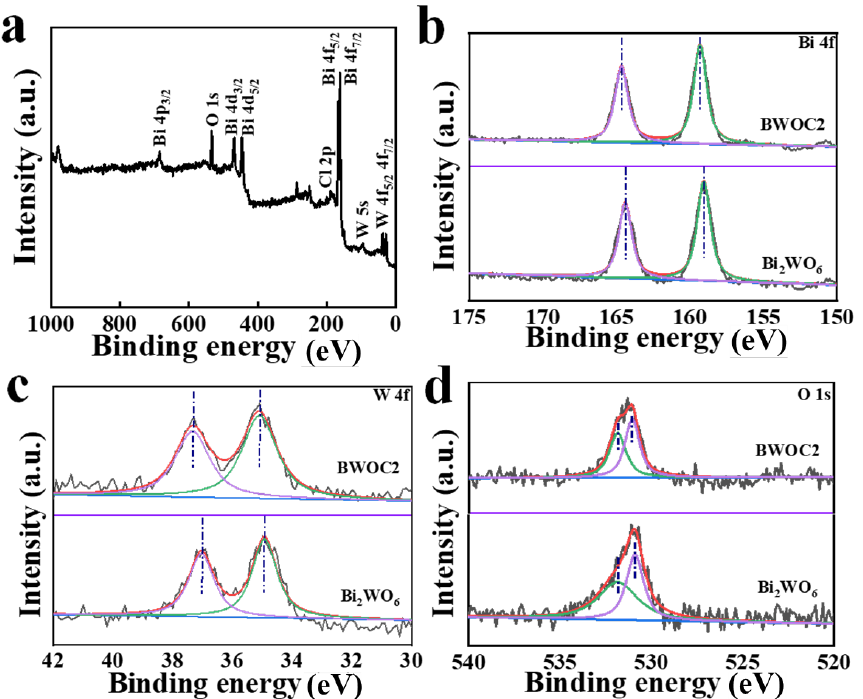
Figure 4. XPS spectra of BWOC2 sample: ( a ) survey spectrum, ( b ) Bi 4f, ( c ) W 4f, and ( d ) O 1s. If the peaks of Bi 4f 7/2 and Bi 4f 5/2 in BWOC2 shift to higher binding energy compared with BWO, the same goes for W peaks. The result is that the electronic density of W 6+ and Bi 3+ decreases, and this induces the increase of binding energy of W 4f and Bi 4f.According to the results of HRTEM of BOC and BWO, oxygen and chlorine atoms are at the end of the (002) plane of BOC and tungsten and bismuth atoms are at the end of the (111) facet of BWO. When the (002) plane of BOC is perpendicular to the (111) facet of BWO, the oxygen atom of BOC may be close to the tungsten atom of BWO, and the chlorine atom of BOC may be near to the bismuth atom of